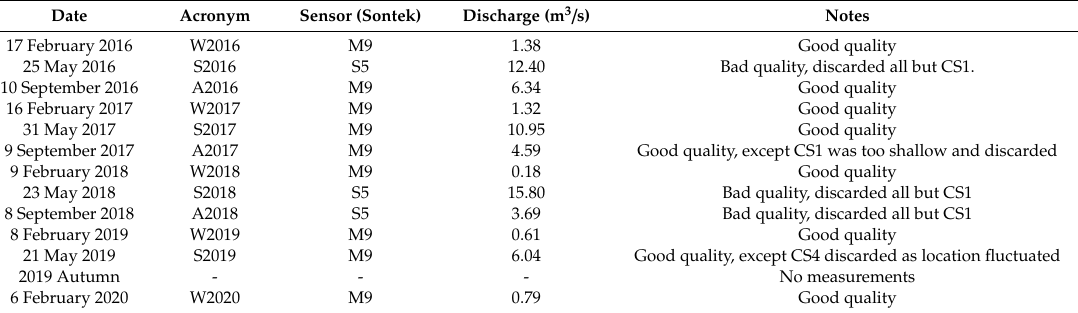
Table 1. The measurement times, applied sensors, discharge, and notes. In the acronyms of the measurement times W = winter (low flow period, February), S = spring (snow-melt flood period, May), A = autumn (low flow period, September). These raw ADCP data sets (Matlab format) are shared with the paper (DOI: 10.5281 / zenodo.3855035). Bad quality relates to the S5 sensor malfunction.